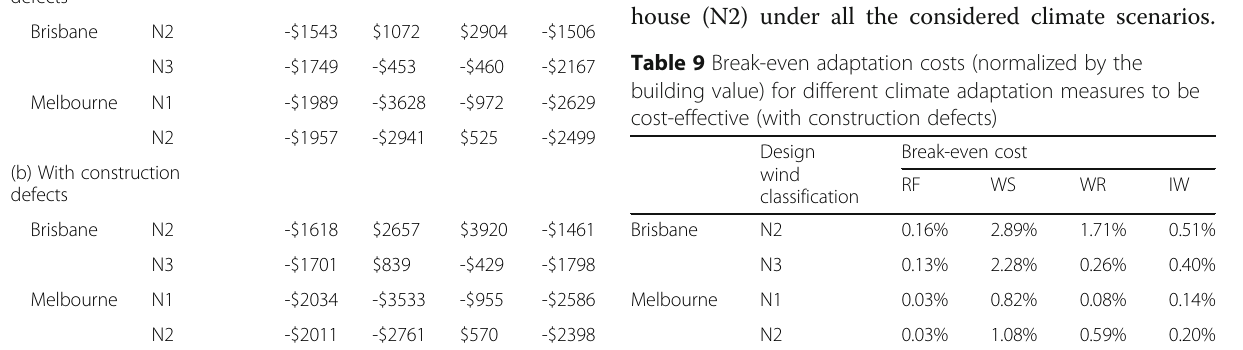
Table 8 Mean NPVs to 2070 with no climate change Design wind